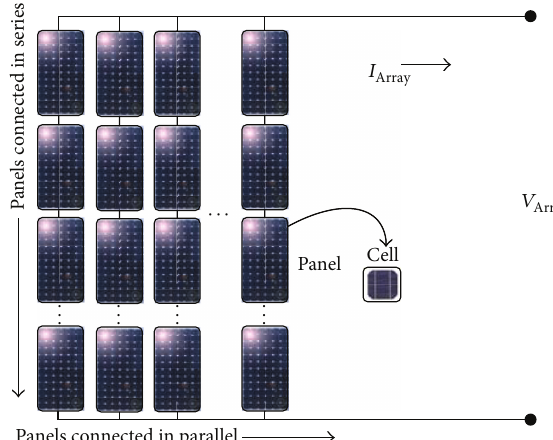
Figure 1: Generic PV array structure.